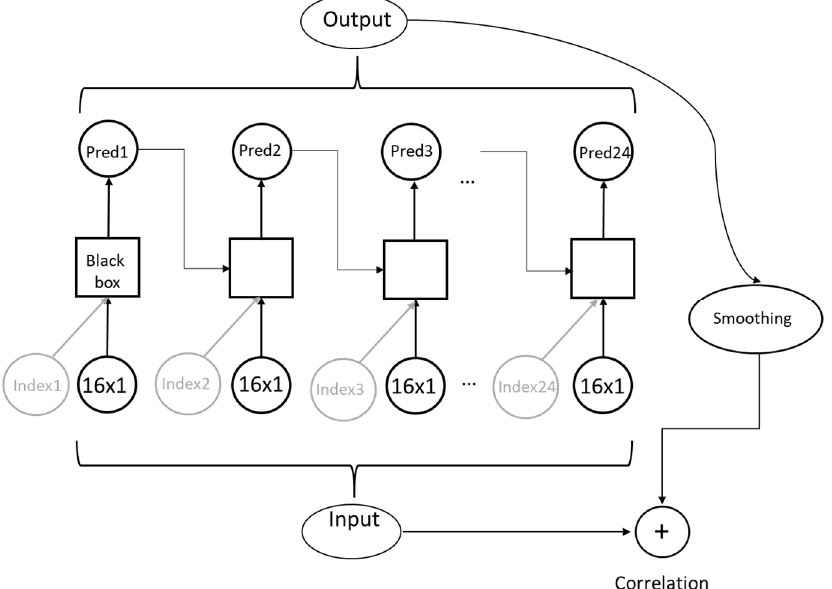
Figure A5. Box chart of the Long Short Term Memory estimation in our paper’s context. Index input signifies one of three monthly indexes (sentiment, stock market returns, and yield on BOC bond). Daily predictions of the indexes are smoothed through post-processing before being compared to the original inputs. The LTSM network was run with default Keras parameters.